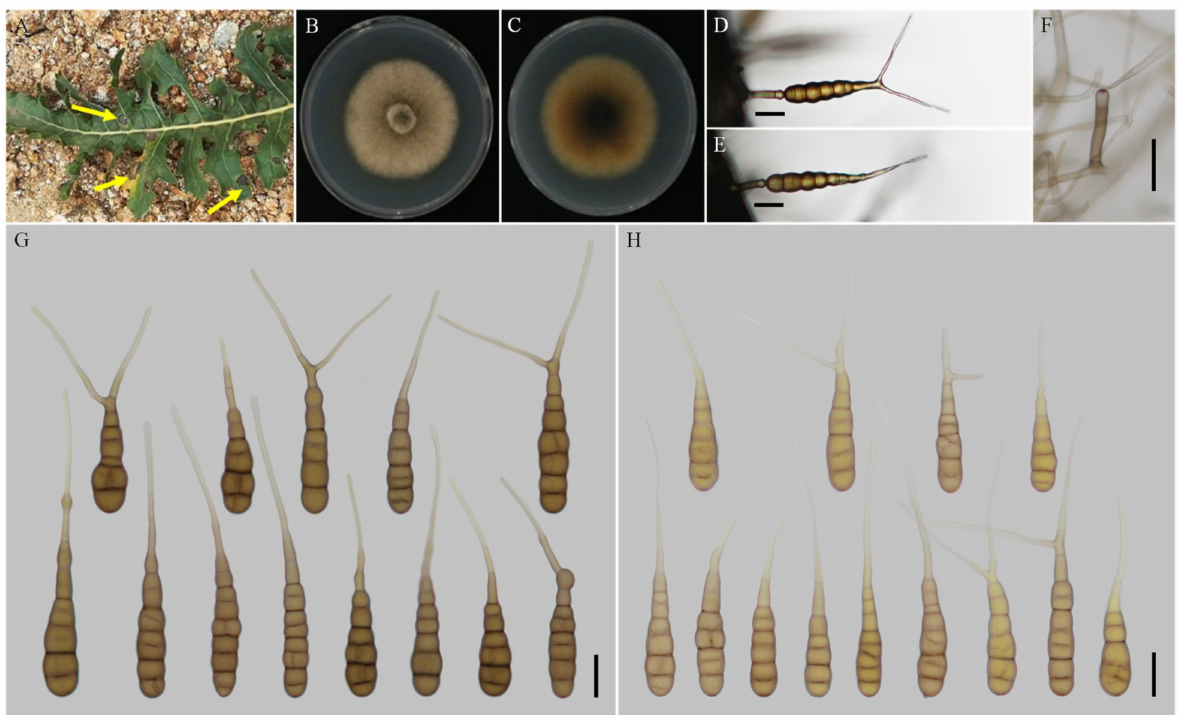
Figure 5. Morphology of Alternaria neimengguensis sp. nov. ( A ) Natural symptoms of Lactuca seriola ; ( B , C ) Colony phenotypes (on PDA for 7 days at 25 ◦ C); ( D , E ) Sporulation patterns (on V8A at 22 ◦ C); ( F ) Conidiophores (on V8A at 22 ◦ C); ( G ) Conidia (on V8A at 22 ◦ C); ( H ) Conidia (on PCA at 22 ◦ C). Bars: ( D – H ) = 25 µ